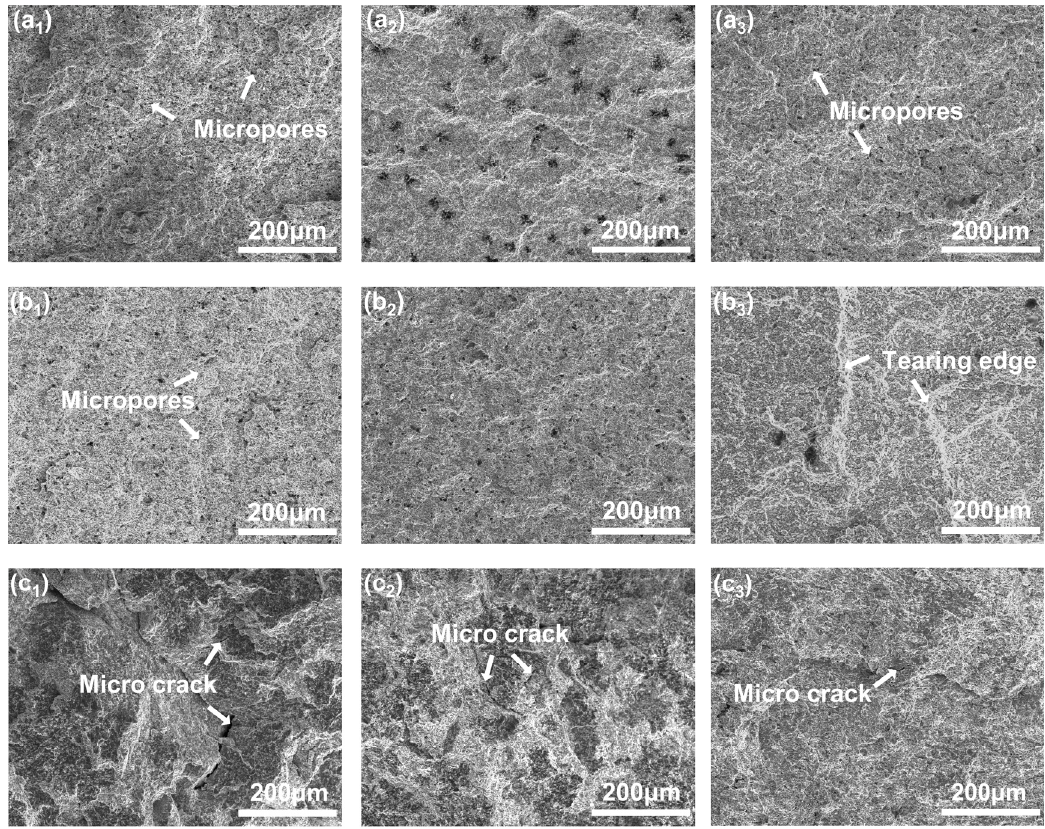
Figure 11. Fractography of ( a ) N, ( b ) NA, and ( c ) NMA composites after tensile test at ( 1 ) RT, ( 2 ) 400 °C, and ( 3 ) 800 °C.